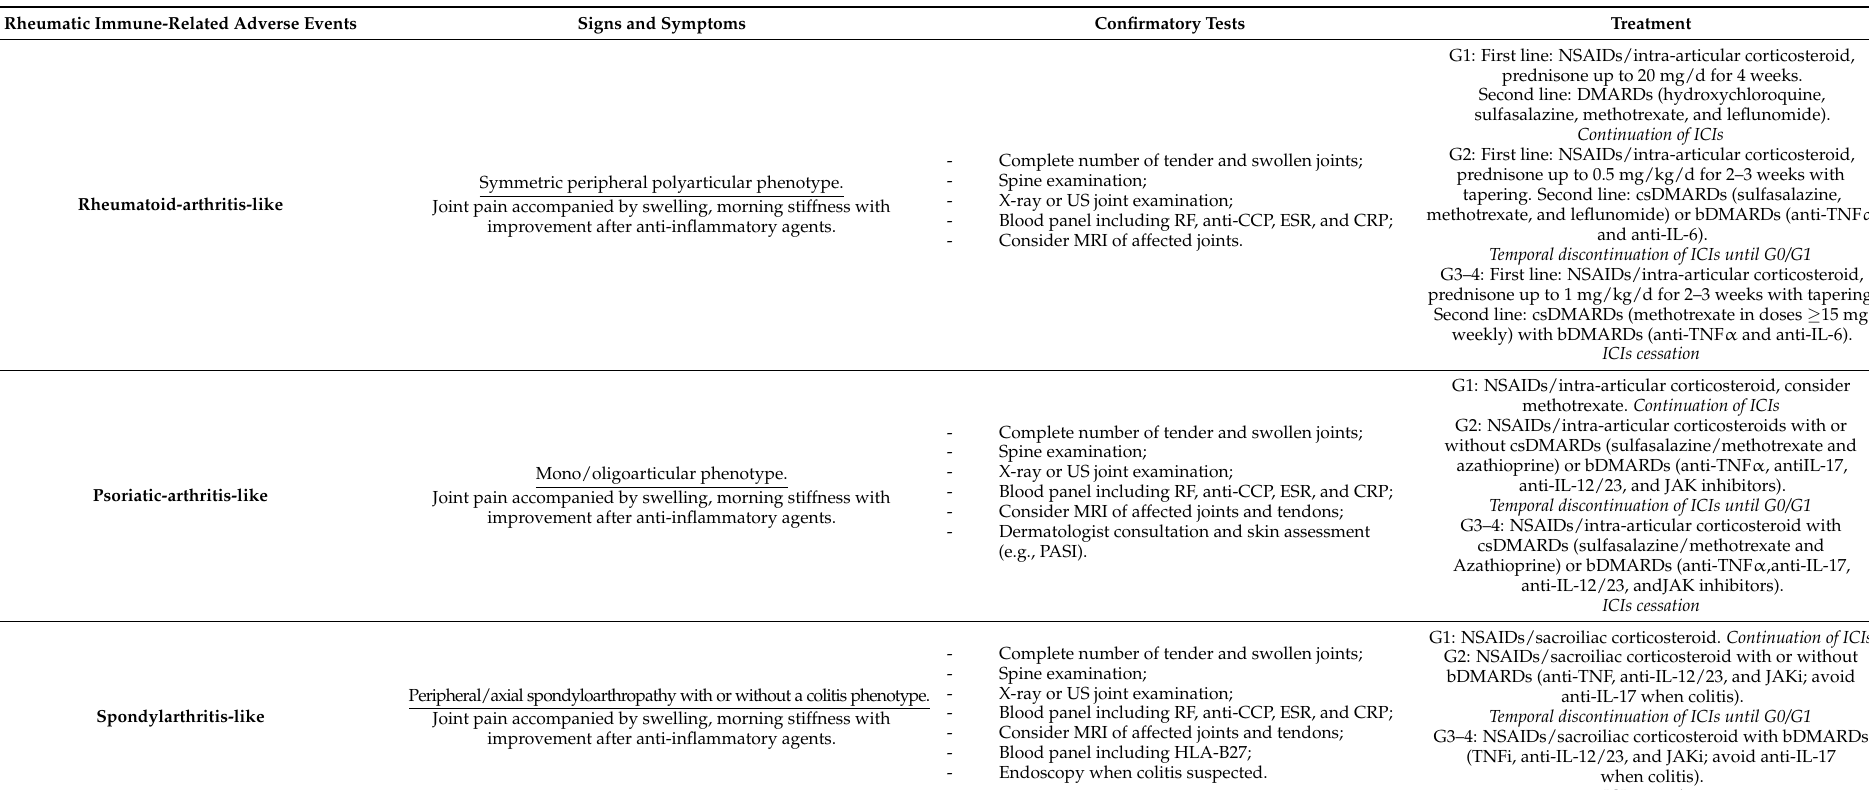
Table 2. Summary of rheumatic complications after immune checkpoint inhibitors with treatment strategies depending on a grade according to the Common Terminology Criteria for Adverse Events version